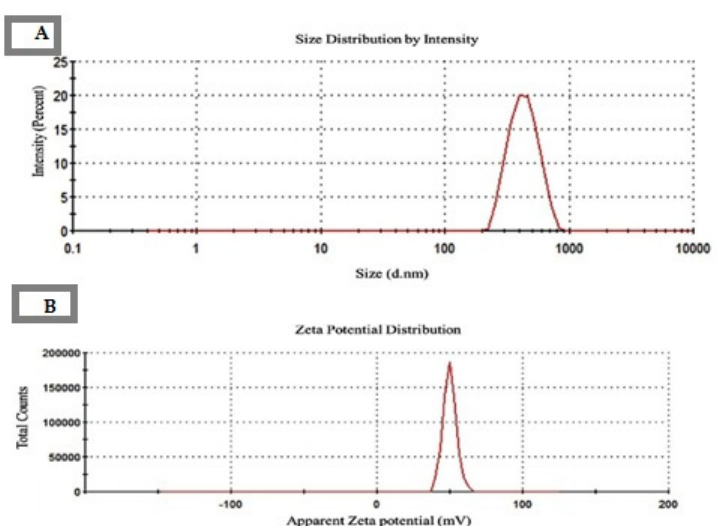
Figure 6. Se/chitosan-folic acid. ( A ) Average size and polydispersity index, and ( B ) Zeta potential range.